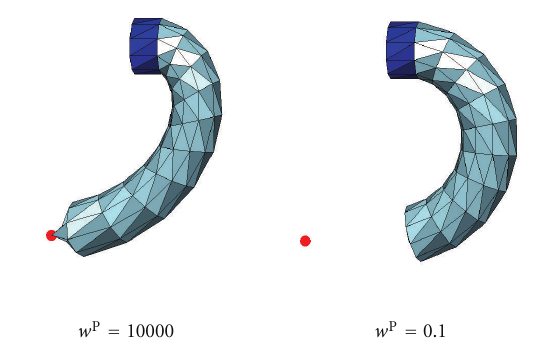
Figure 16: The e ff ect of using a small weight for position constraints. Using a small value for w P , we can avoid violating the smoothness around the handle.